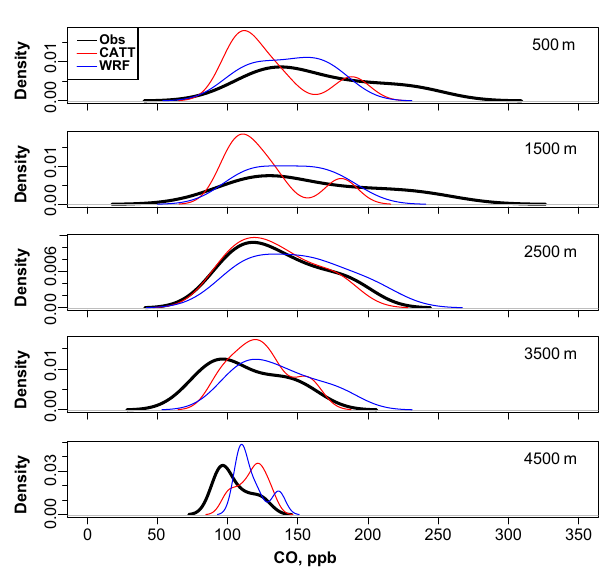
Fig. 13. Probability density distributions for CO concentrations in BARCA-A, by altitude (excluding Manaus vicinity), for the CATT- BRAMS and WRF-Chem models, compared to observations.